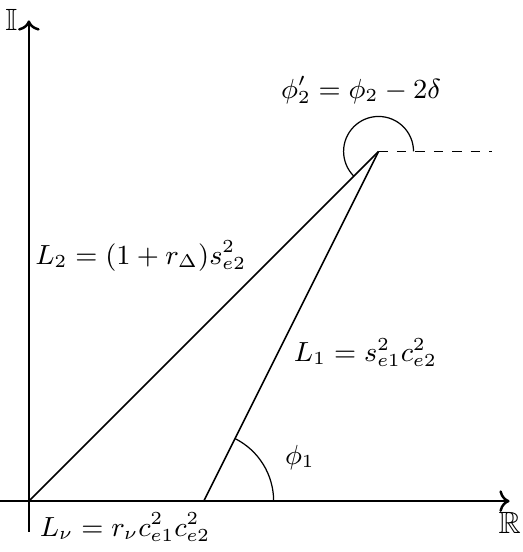
Figure 1 . Visualisation of the ( sides are given in terms of the dimensionless ratios r (cid:23) = m (cid:23) =m N